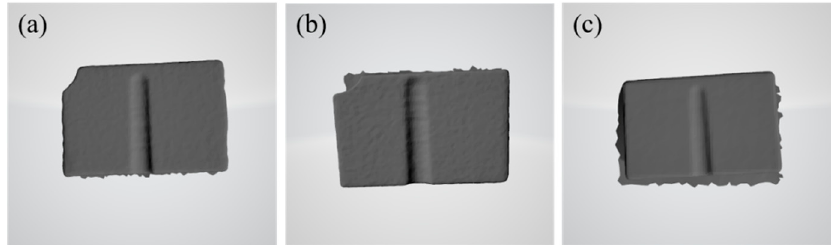
Figure 4. 3D virtual model of the lithium disilicate model after cutting using ( a ) S-max M400, ( b ) TG-98, ( c ) TRAUS ATN-400.